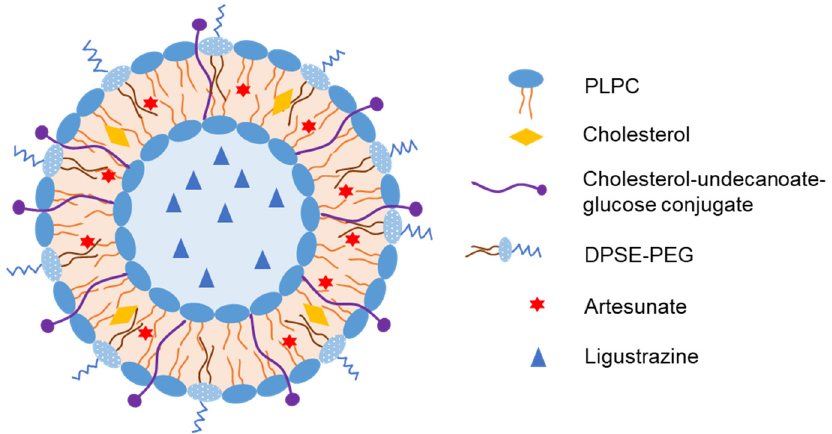
Figure 3. Representative structure of liposomes loaded with artesunate and ligustrazine with cho- lesterol–undecanoate–glucose conjugate to target glucose transporter 1 at the BBB for treatment of cerebral malaria [37]